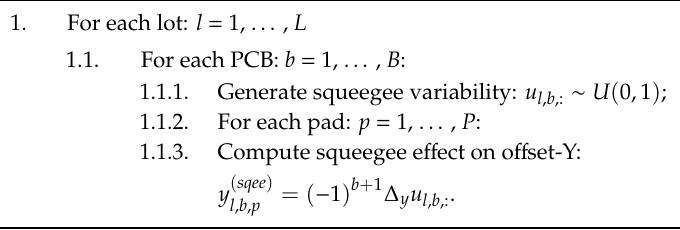
Table 5. Pseudo-code for generating the squeegee e ff ect on o ff set-Y.